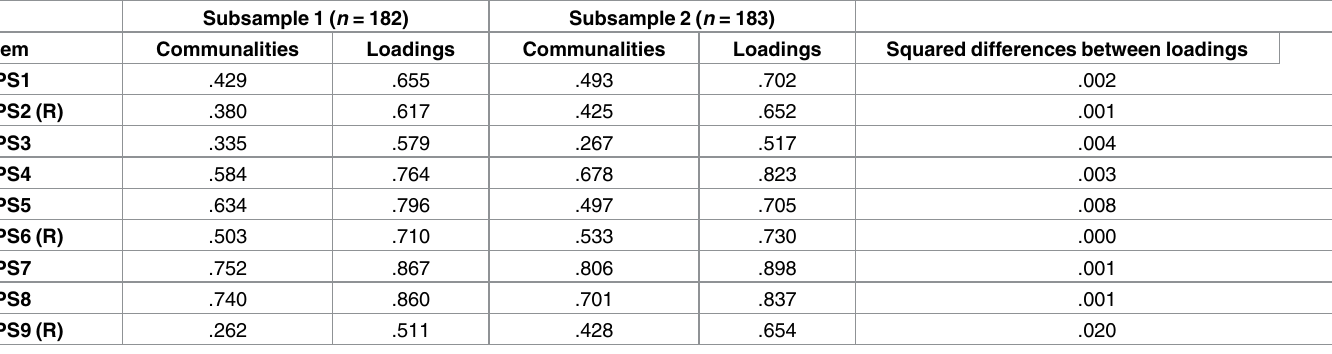
Table 3. Communalities and factor loadings in each subsample, and the squared differences between loadings. Subsample 1 ( n =